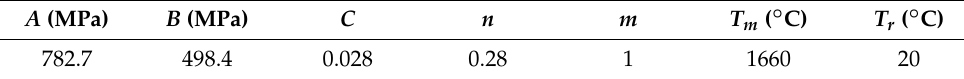
Table 1. Johnson-Cook parameters for Ti6Al4V alloy [38].